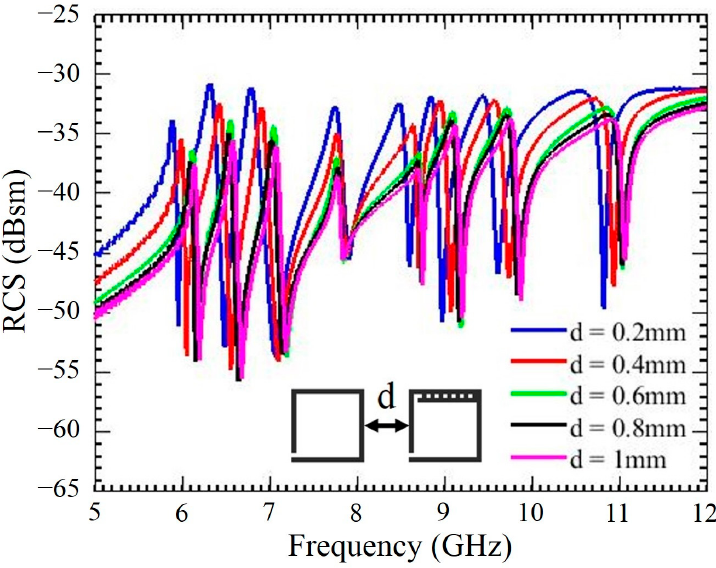
Figure 10. Effect of inter-resonator separation on RCS response of the tag.